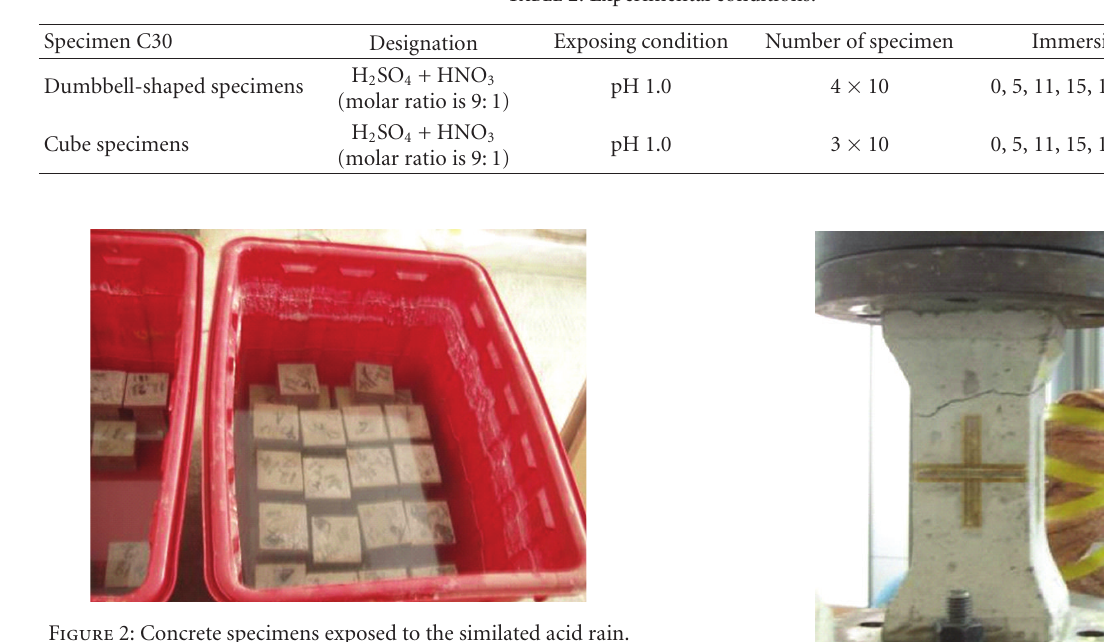
Table 2: Experimental conditions.